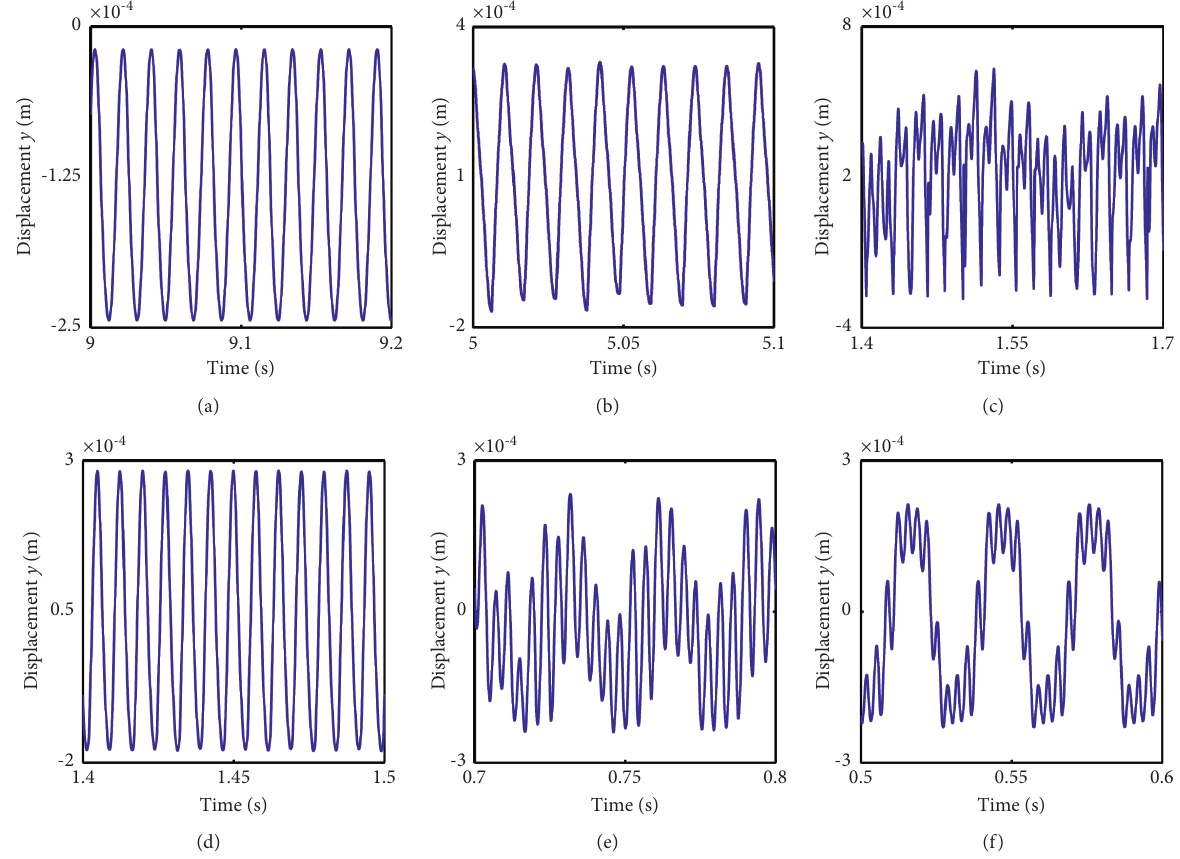
Figure 8: Vibration waveforms of the right journal. (a) ω � 3200r/min, (b) ω � 5700r/min, (c) ω � 6900r/min, (d) ω � 8000r/min, (e) ω � 14400r/min, and (f) ω � 18000r/min.